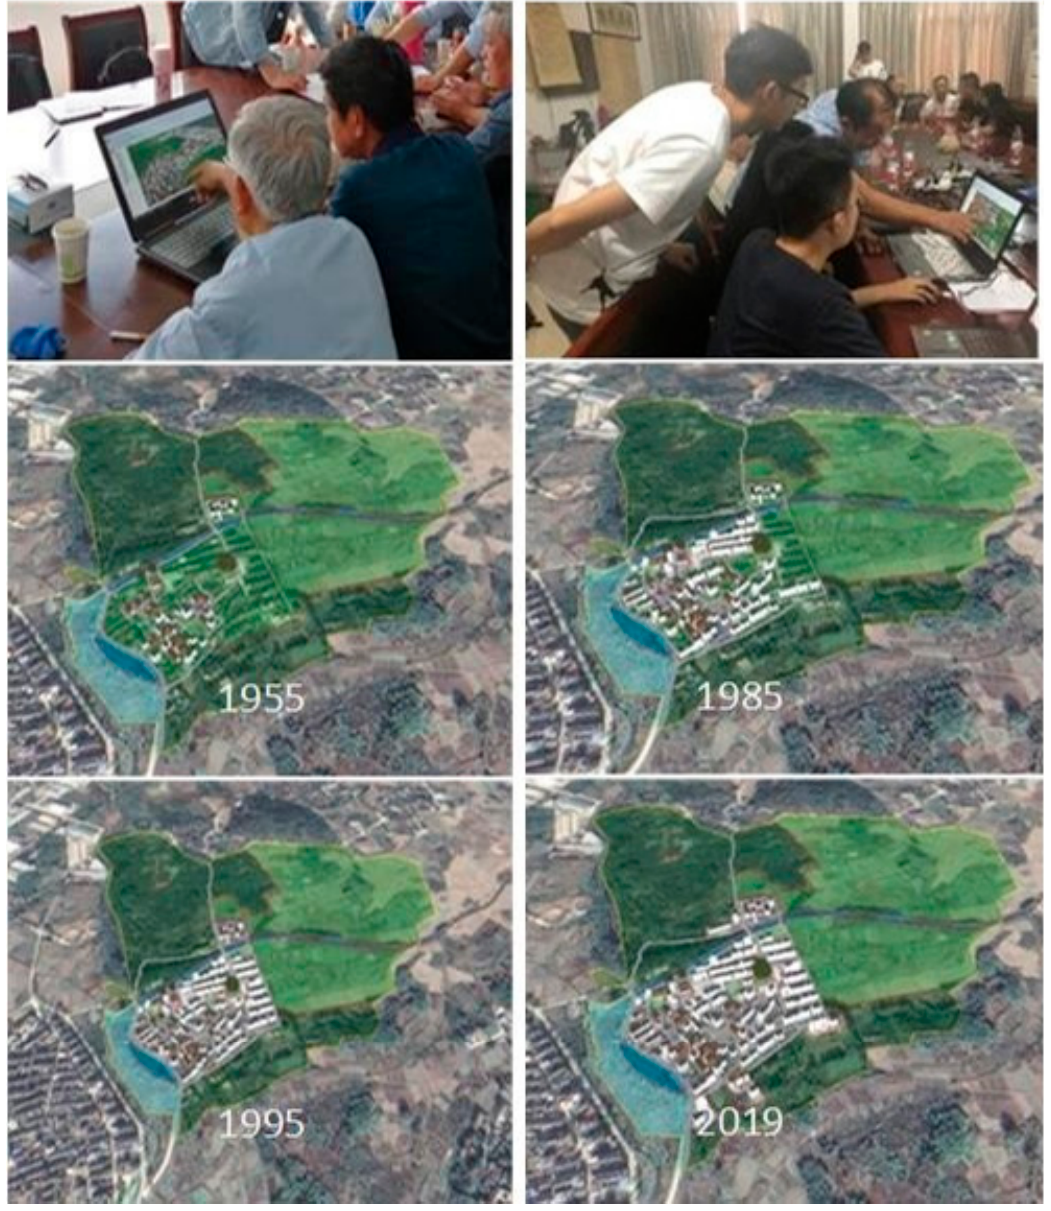
Figure 7. Data collection and present status analysis using XYEarth during phases 1 and